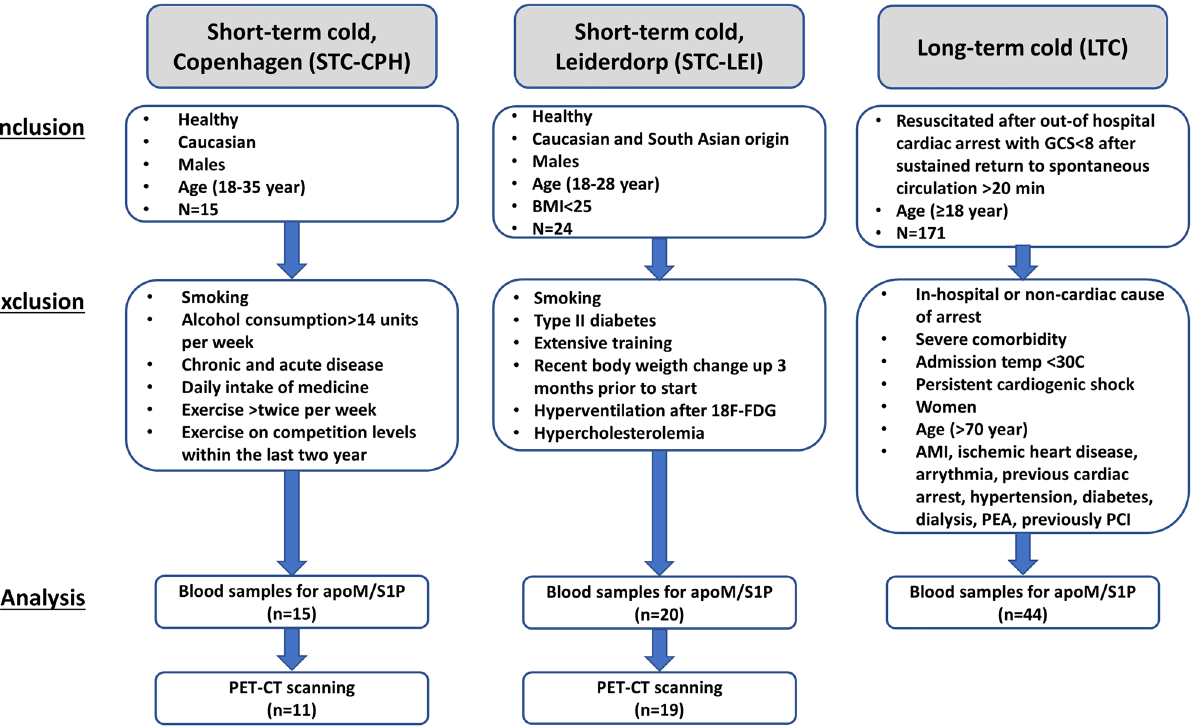
Figure 1. Flow charge of the three included studies and the exclusion